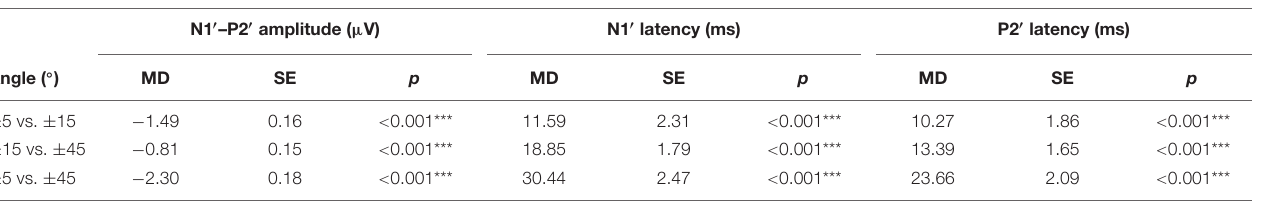
FIGURE 3 | The averaged ( n = 33) ACC waveform at Cz elicited by (A) rightward location change and (B) leftward location change across different test angles. This figure showed the overlying waveform of EEG ( n = 33) at electrode Cz while the sound location change was rightward (A) and leftward (B) . The ordinate represented the amplitude of the waveform, and the positive value was upward. The abscissa represented one sound playing cycle. The sound started playing at 0 ms, changed its position at 500 ms, and ended at 1,000 ms. The onset-CAEP appeared within 50–250 ms. A similar waveform, which was ACC, appeared within 600–800 ms (the sound change happened at 500 ms). Clear waveforms can be observed under the conditions of [–45 ◦ , +45 ◦ ] (blue line), [–15 ◦ , +15 ◦ ] (green line), [–5 ◦ , +5 ◦ ] (purple line), and [–2 ◦ , +2 ◦ ] (yellow line). Baseline waveform was obtained by presenting the same stimulus without any changes to 10 of 33 participants at –45 ◦ . The CAEP waveforms elicited under different conditions almost coincided. After overlapping ACC waveforms under different conditions, it can be seen that the latency of N1 (cid:48) and P2 (cid:48) tends to shorten and the N1 (cid:48) –P2 (cid:48) amplitude tends to increase with the increase of test angle regardless of the location change direction. TABLE 4 | Comparisons of ACC between different test angles at